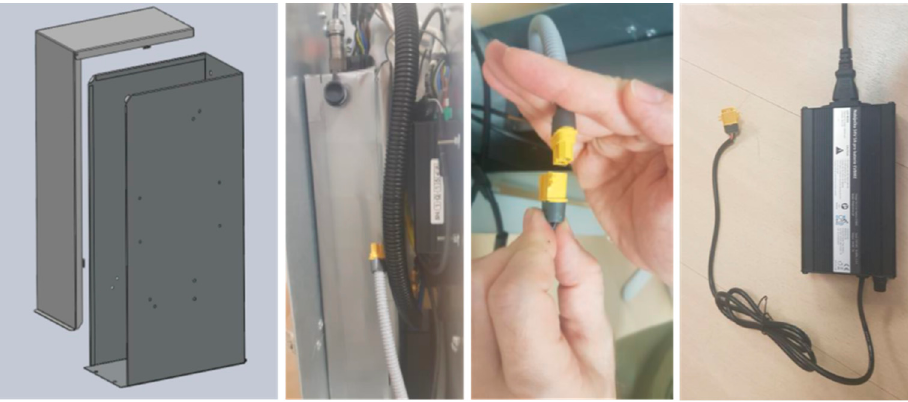
Figure 3. Battery box and its internal components (BMS, current sensor, battery, and charging